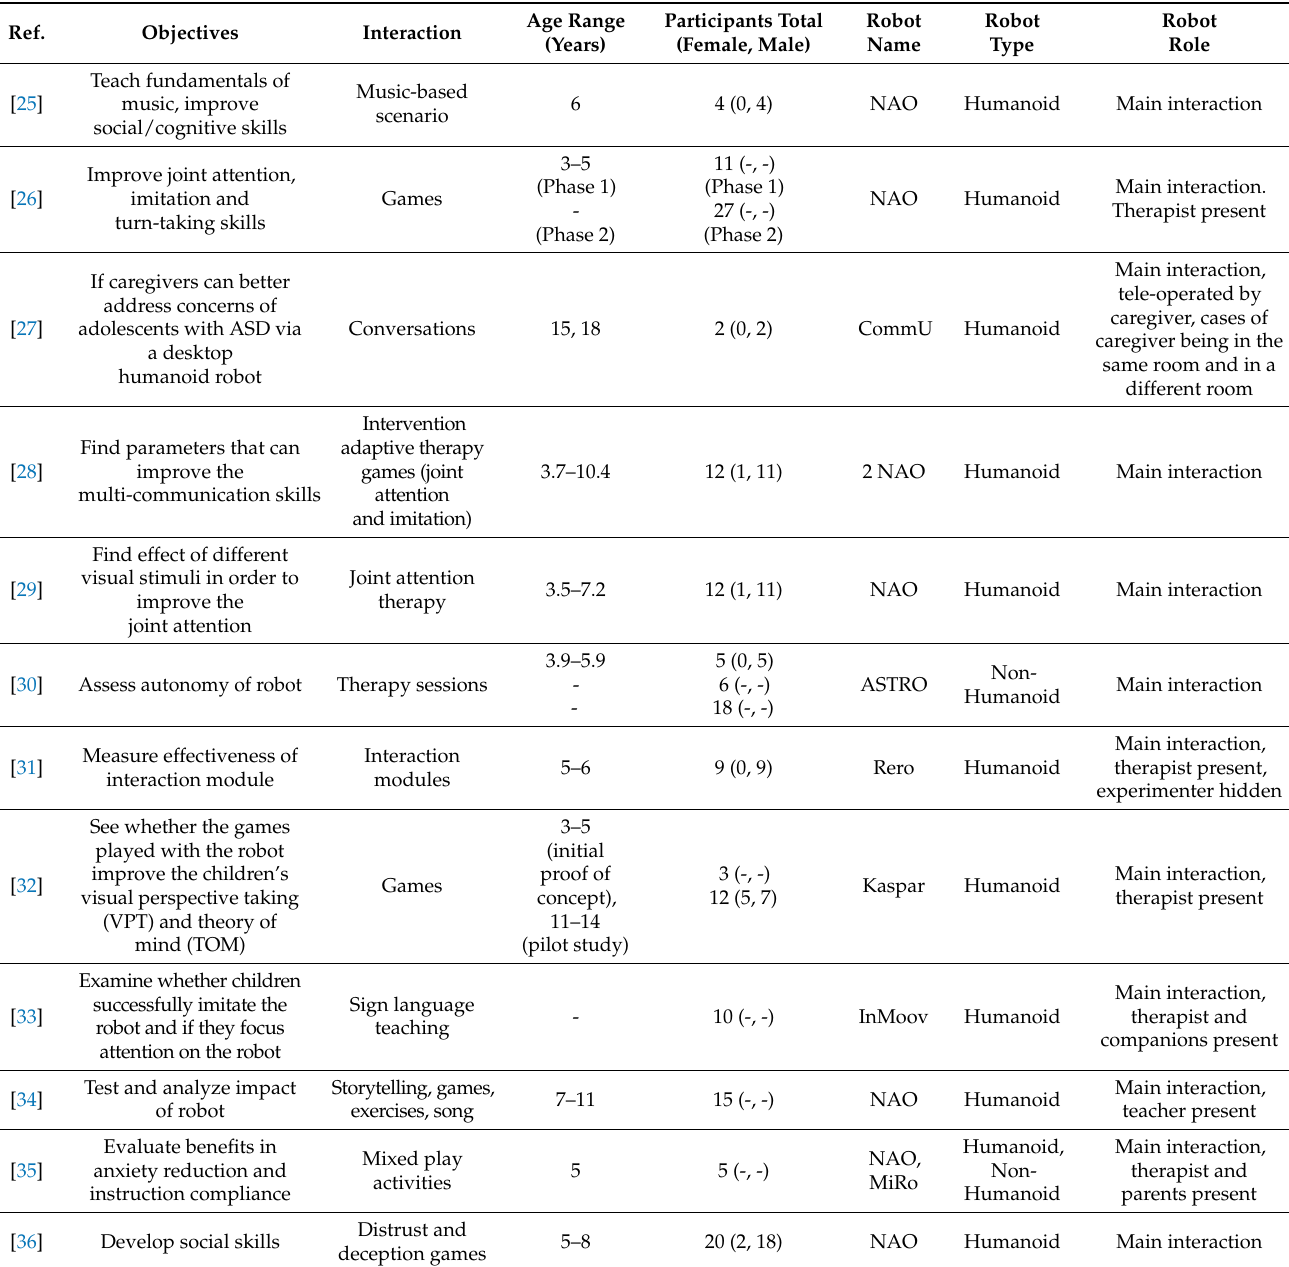
Table 1. Quantitative information of the examined ASD